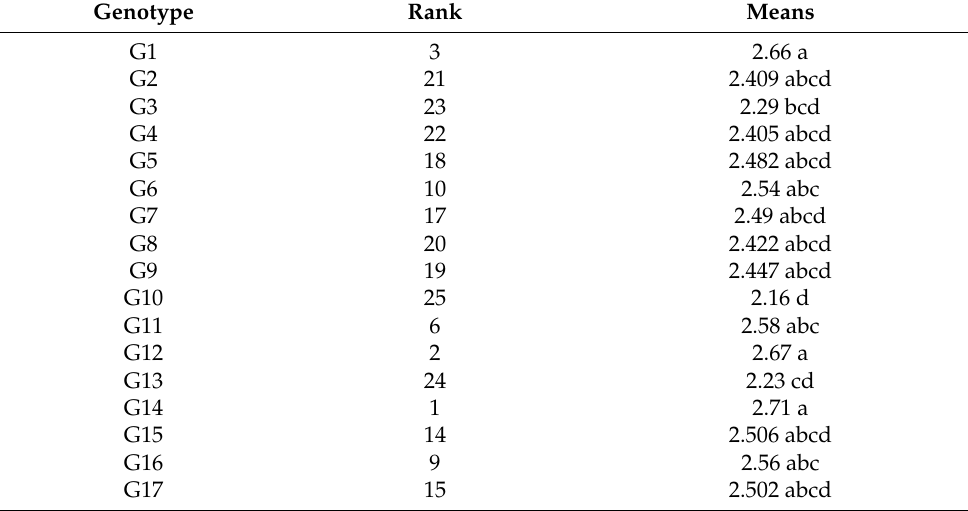
Table 5. Comparison of Duncan’s mean grain yield in two cropping years and five test